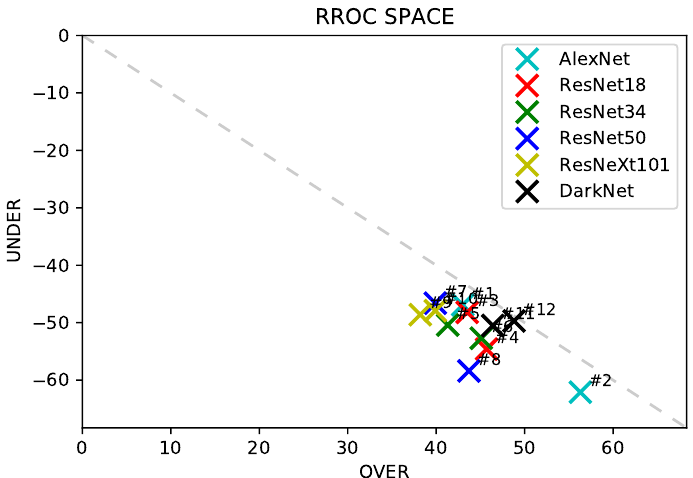
Figure 7. Regression Receiver Operating Characteristic (RROC). The experiments are represented by their number according to Table 3.